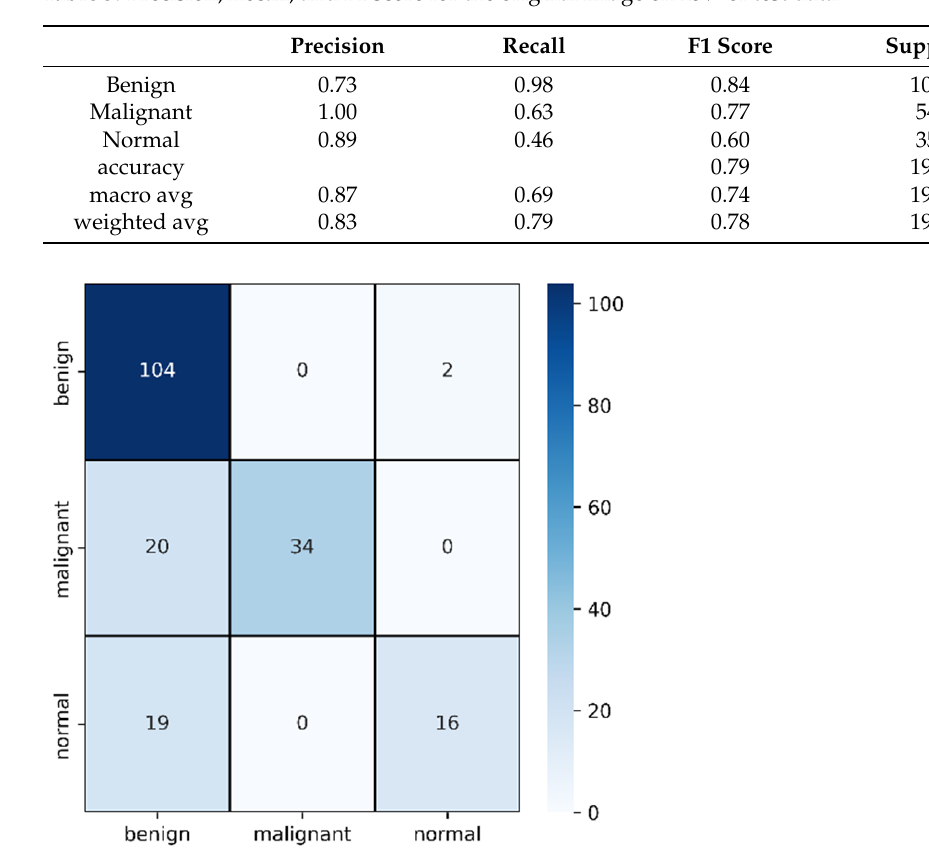
Table 3. Precision, Recall, and F1 score for the original image on 25% of test data.